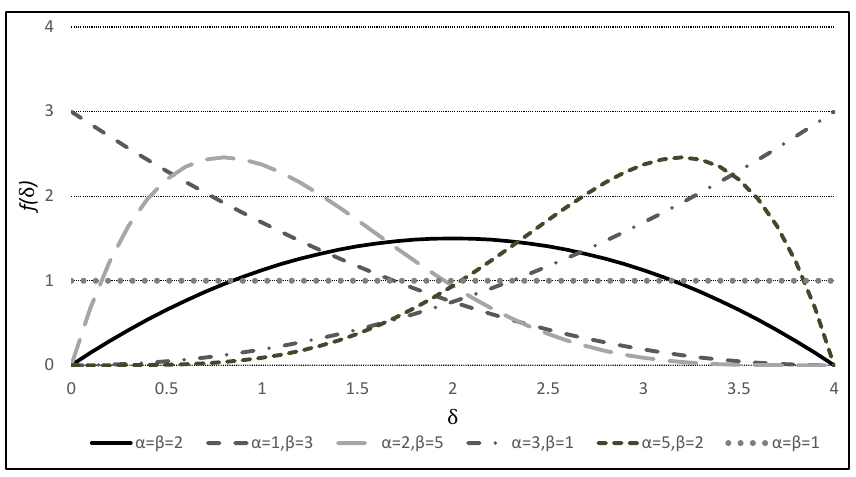
Table 6. Optimal weighted 𝐀𝐑𝐋